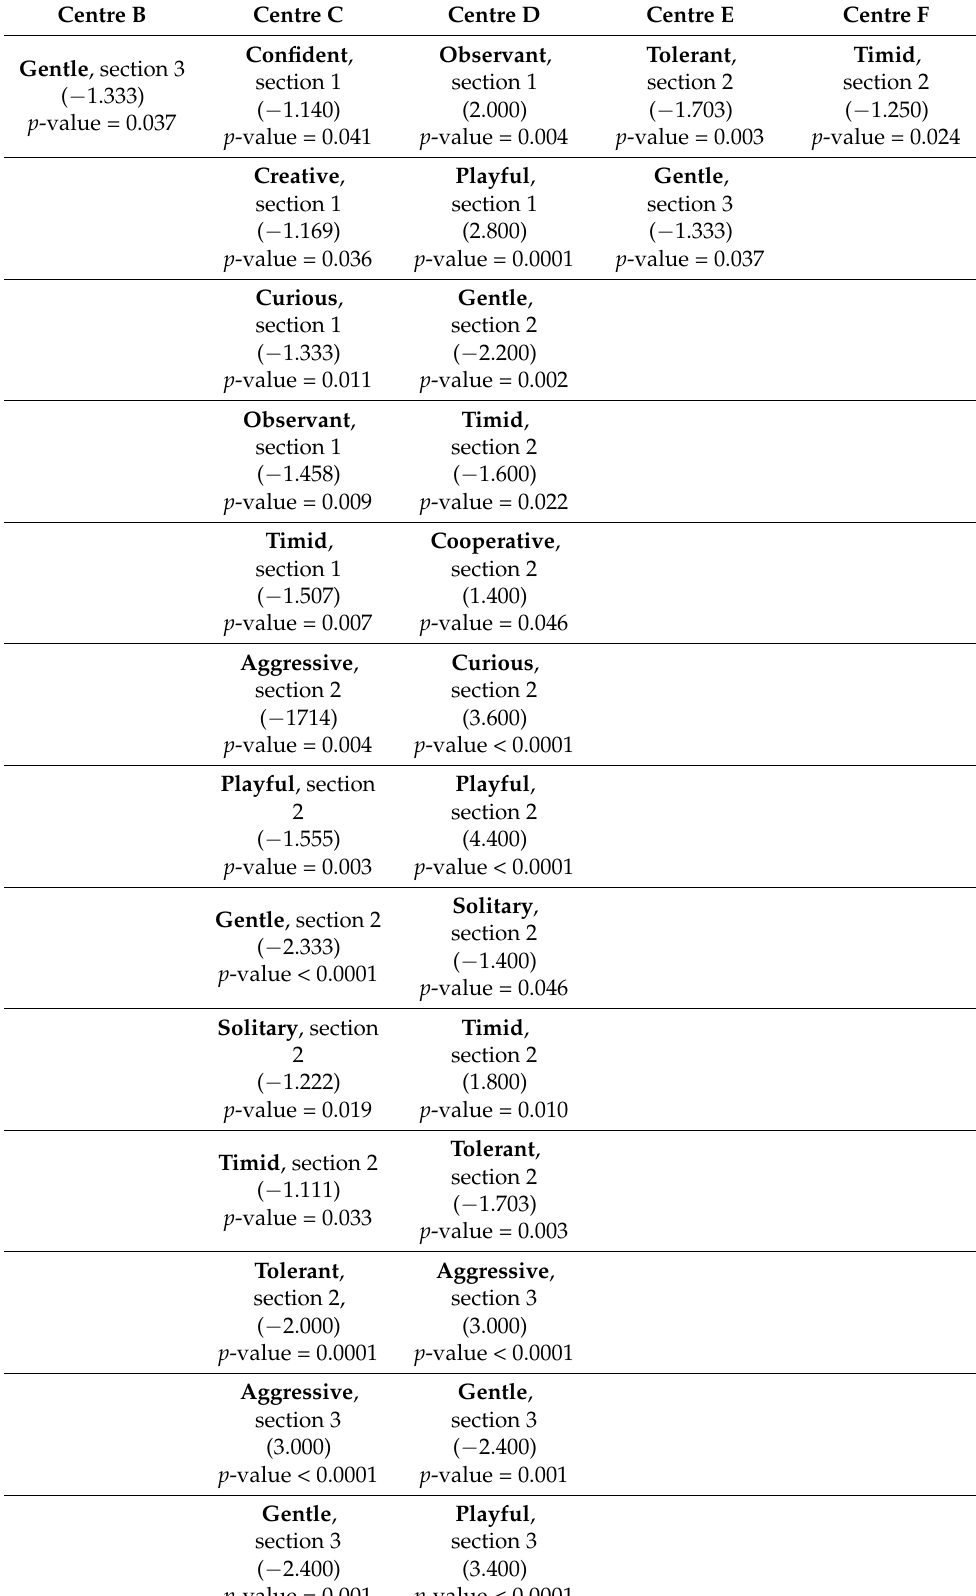
Table 4. Statistically significant (5% significance level) mean differences in scores between tests 1 and 2 for centre, section, and adjective (in